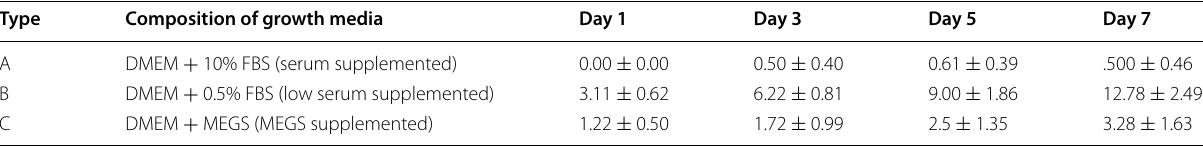
Table 3 Mammosphere-forming efficiency of stem-like cells in growth media A, B, and C